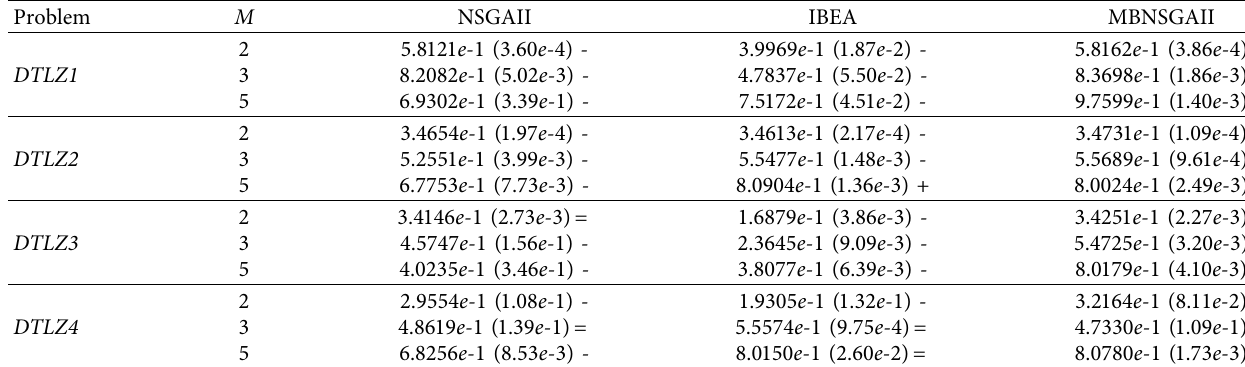
Table 4: Experimental results of HV on several DTLZs (mean and standard deviation).